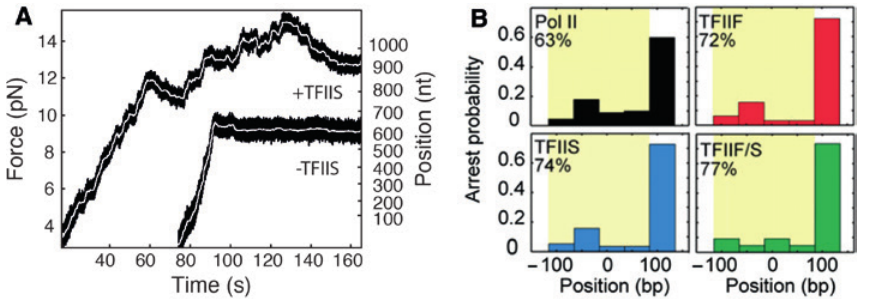
Figure 4: Elongation in the presence of transcription